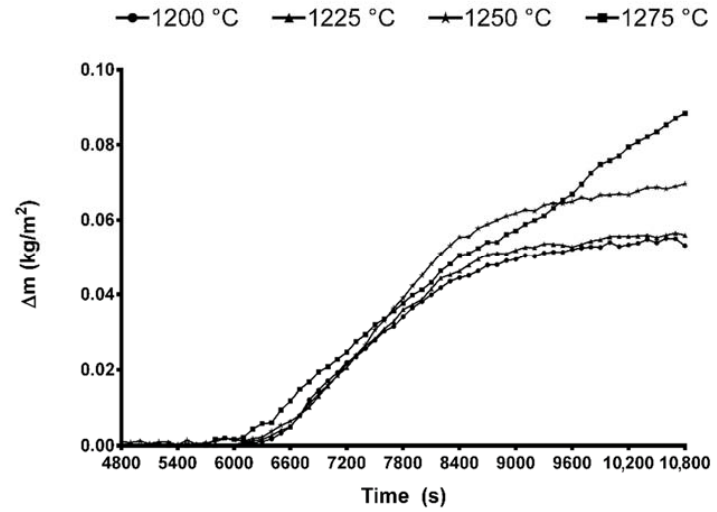
Figure 6. TG results from lean oxyfuel atmosphere.